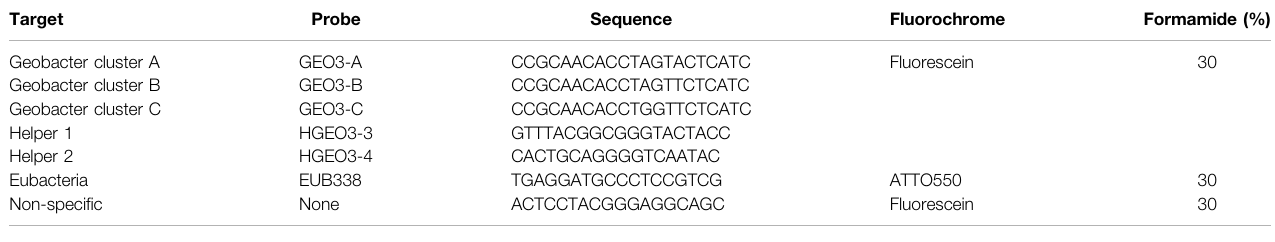
TABLE 1 | Probes used for FISH.